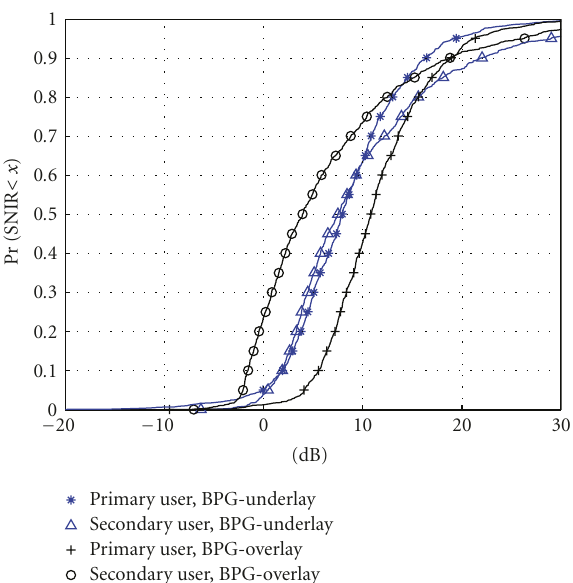
Figure 9: SINR results: overlay versus underlay, for PUs and SUs.